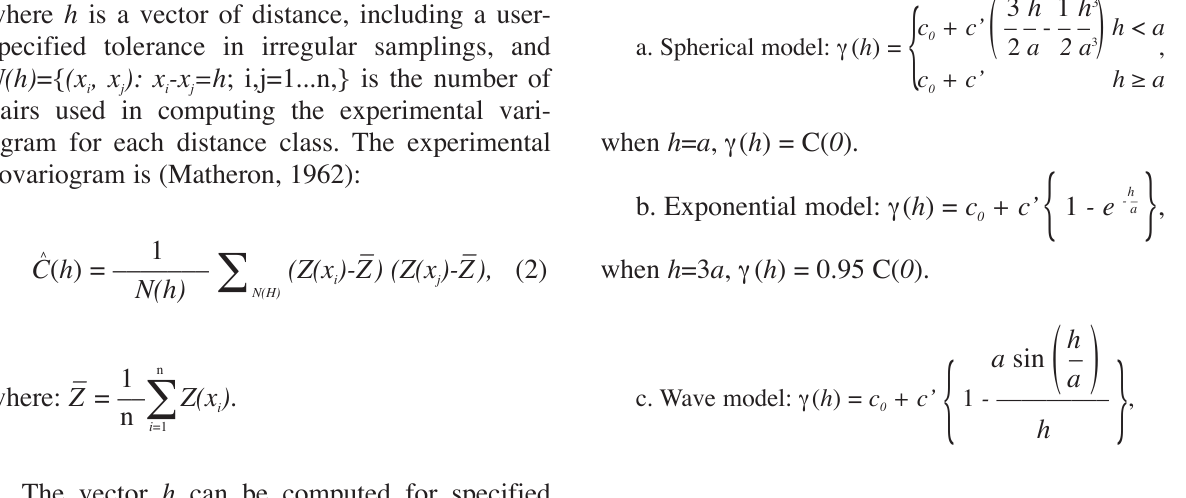
{ } h b. Exponential model: γ ( h ) = c + c’ 1 - e - – a , 0